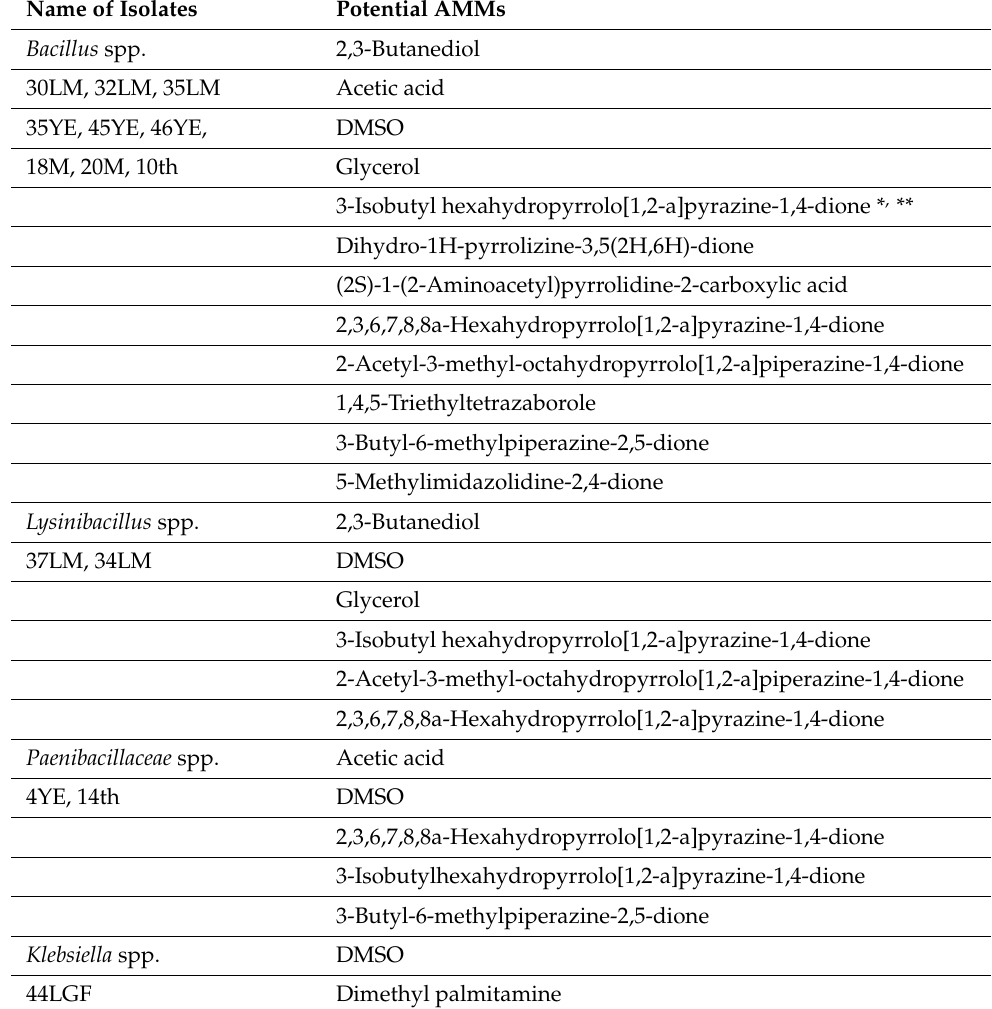
Table 3. Summary of metabolites from biocontrol bacteria detected by GC/MS with potential antimicrobial